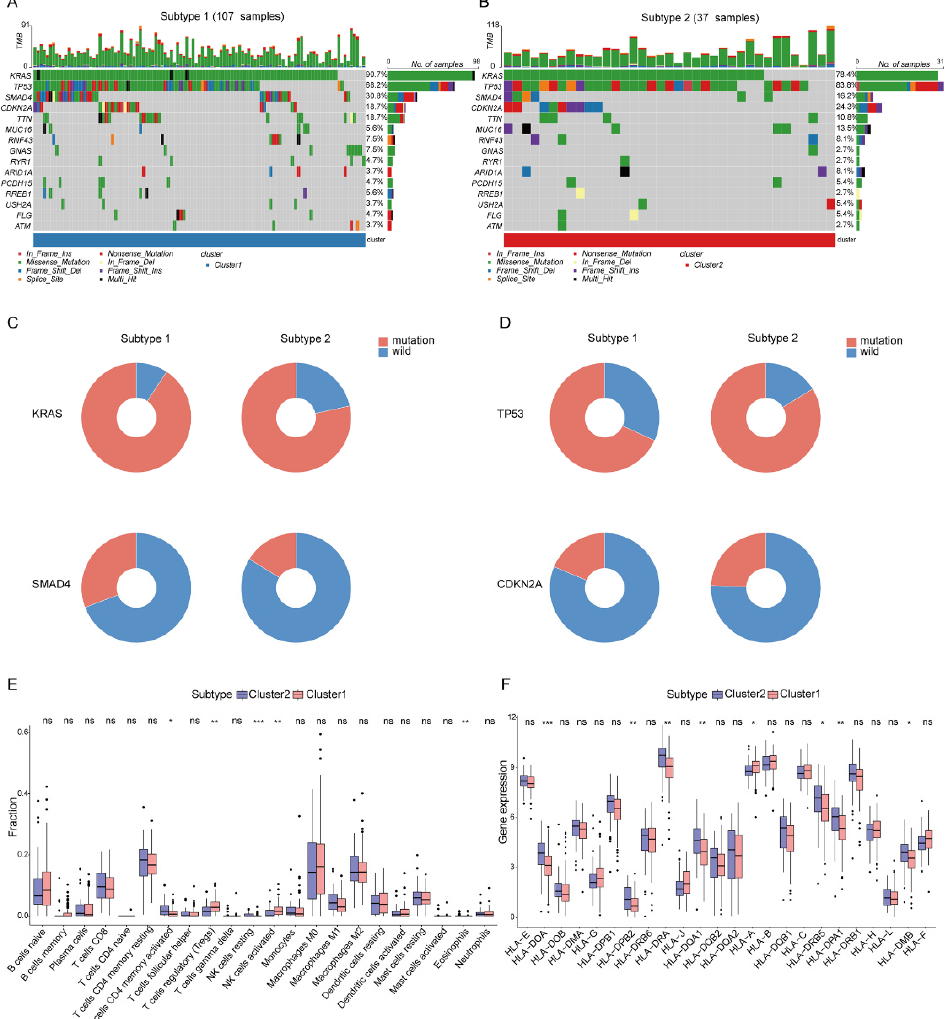
Figure 3. Somatic mutation and immune features between subgroups. Landscape of mutation profiles in DDR-subtype1 ( A ) and DDR-subtype2 ( B ). Mutation information of each gene in each sample is shown in the waterfall plot. Top panel shows individual tumor mutation burden. ( C ) Patients with DDR-subtype1 showed higher mutation frequencies of KRAS and SMAD4; ( D ) Patients with DDR-subtype2 showed higher mutation frequencies of TP53 and CDKN2A. Immune profile alterations ( E ) and human leukocyte antigen ( F ) between the DDR-subtypes. * represents p < 0.05, ** represents p < 0.01, *** represents p < 0.001, ns represents no significant difference.